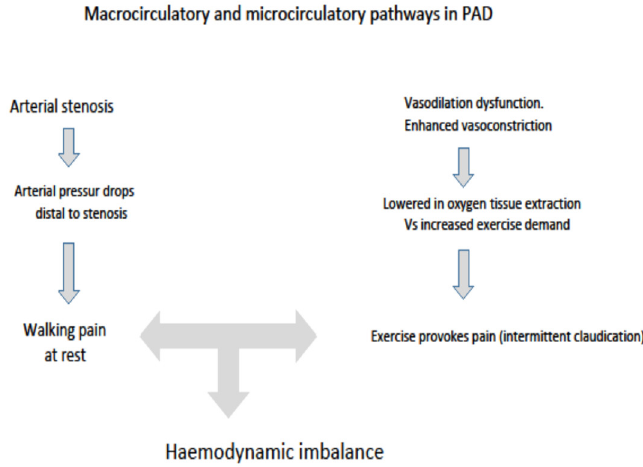
Figure 1. Macrocirculatory and microcirculatory mechanisms in compromising walking capability in peripheral chronic ischemia.